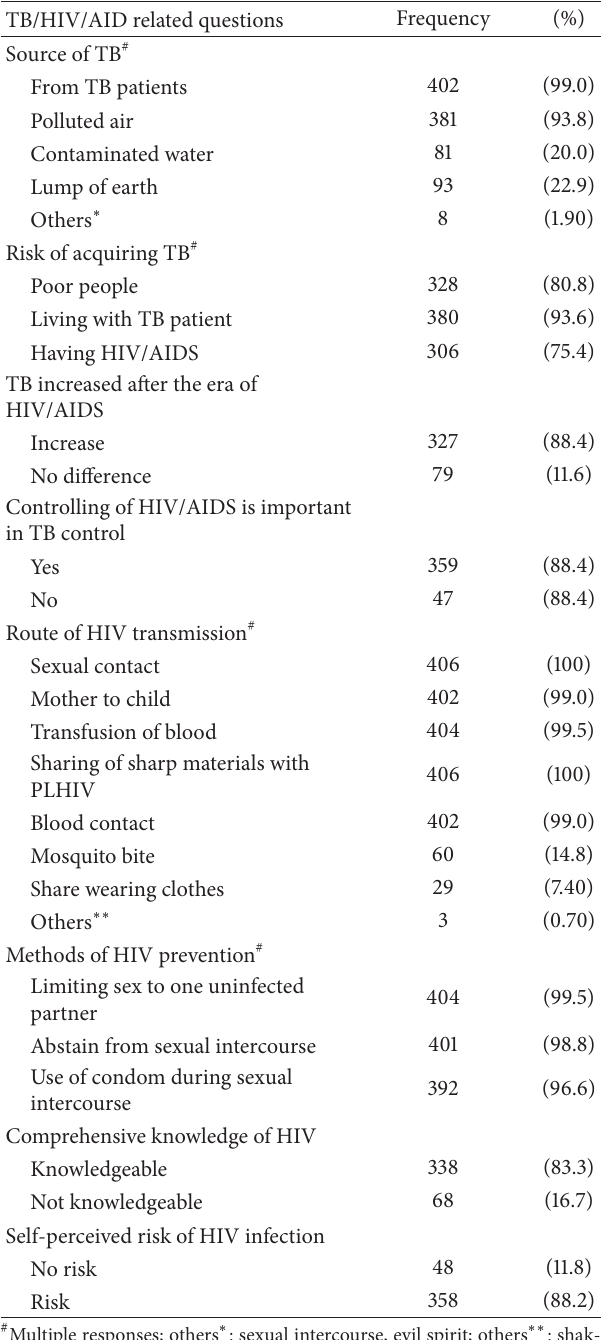
Table 2: Knowledge related to TB/HIV/AIDS among tuberculosis patients in East Wollega administrative zone at selected health cen- ters, August 2010, ( 𝑁 = 406